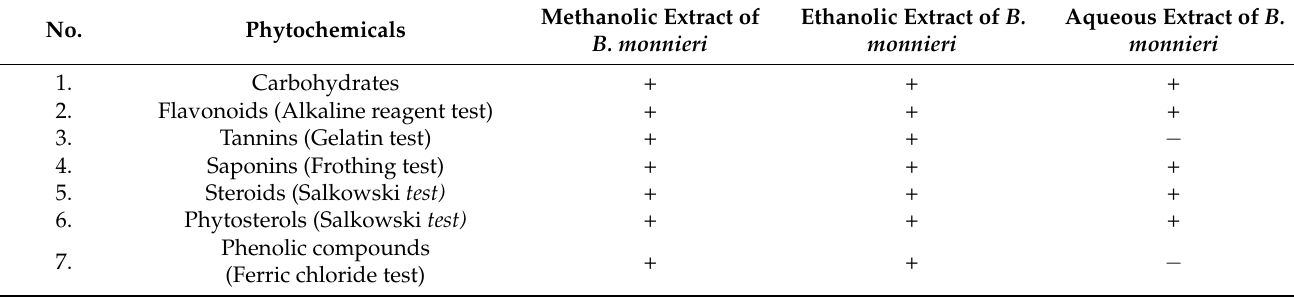
Table 2. Phytochemical analysis of crude extracts of B. monnieri